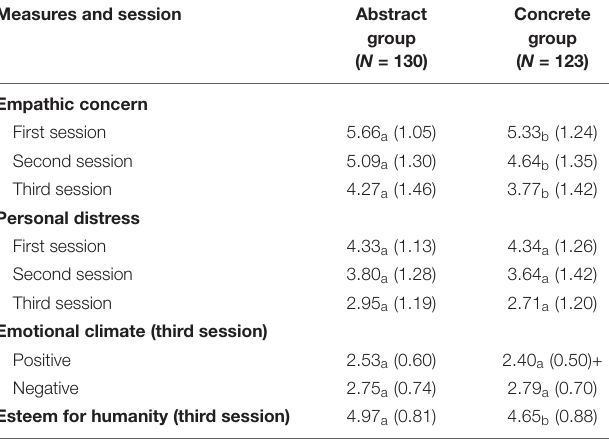
TABLE 3 | Descriptive statistics and construal level: means